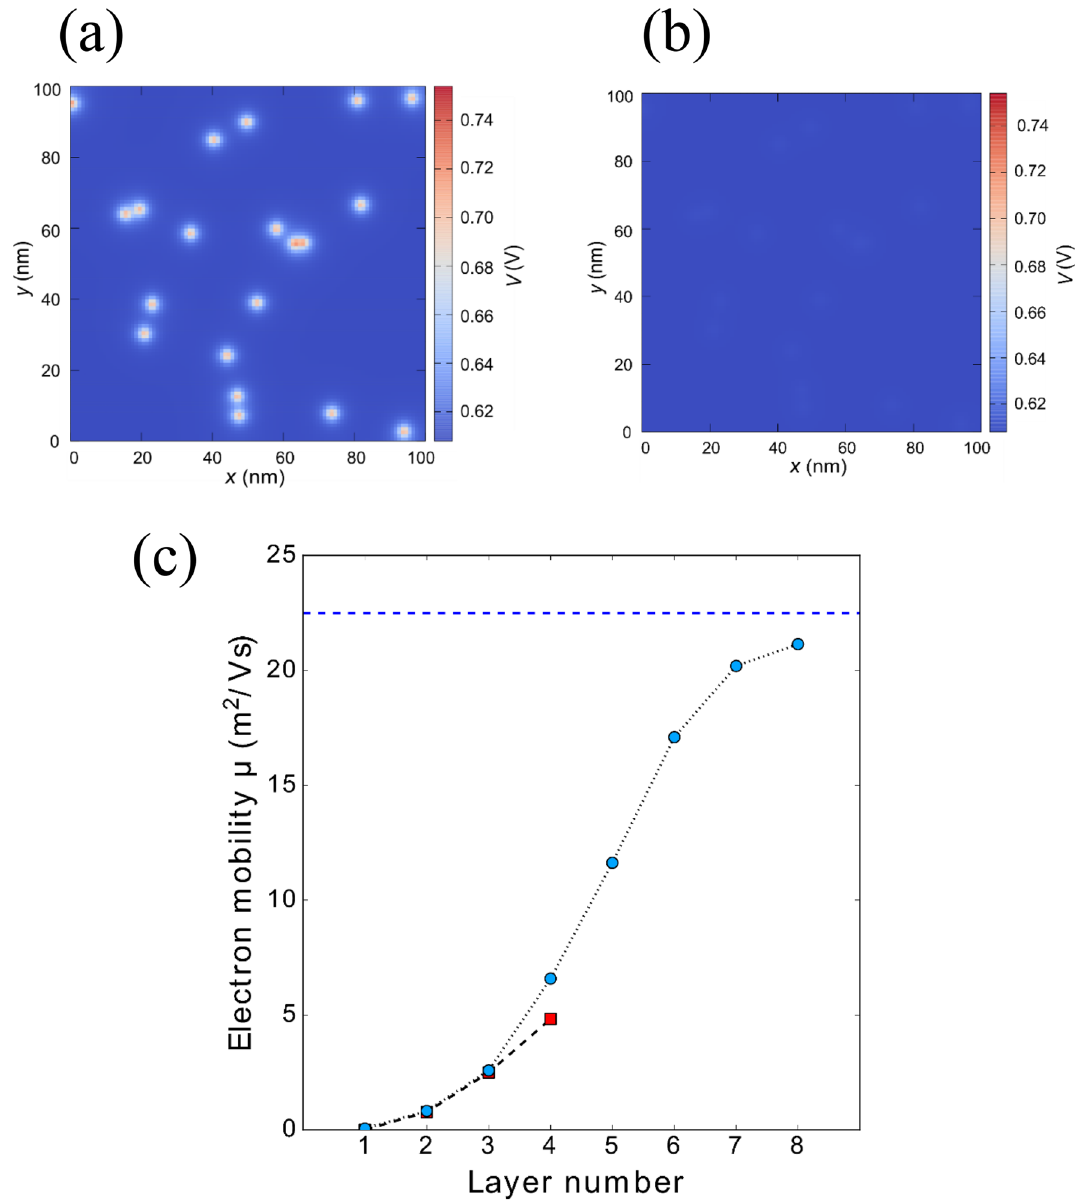
Figure 7. Self-consistent potential profiles at ( a ) the bottom layer and ( b ) the top layer in the multilayer GNR composed of 8 layers on the SiO 2 substrate when the density of charged impurity is 2 × 10 11 cm −2 . ( c ) Is calculated electron mobility vs the number of layers. The multilayer GNR channels with 4 and 8 layers are described by red squares and blue circles,